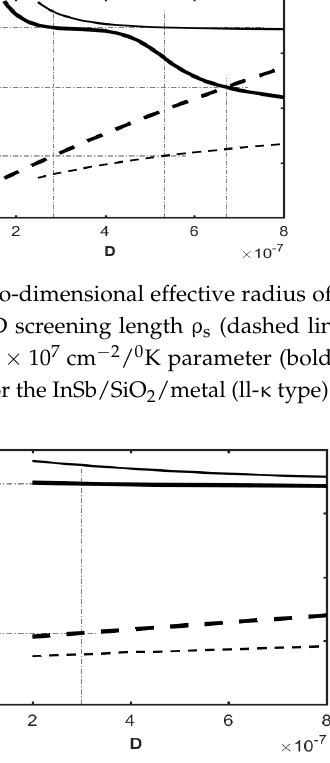
Figure 4. Two-dimensional effective radius of the screened impurity bound state a sc ≈ λ − 1 (solid lines) and 2D screening length ρ s (dashed lines) as a function of the oxide thickness D with the n s /T| a ≈ 6.6x10 7 cm − 2 / 0 K parameter (bold lines) and n s /T| b ≈ 6.6x10 8 cm − 2 / 0 K parameter (thin lines) for the InSb/S/HfO 2 /metal (lh- κ type) multi-layer quantum structure.